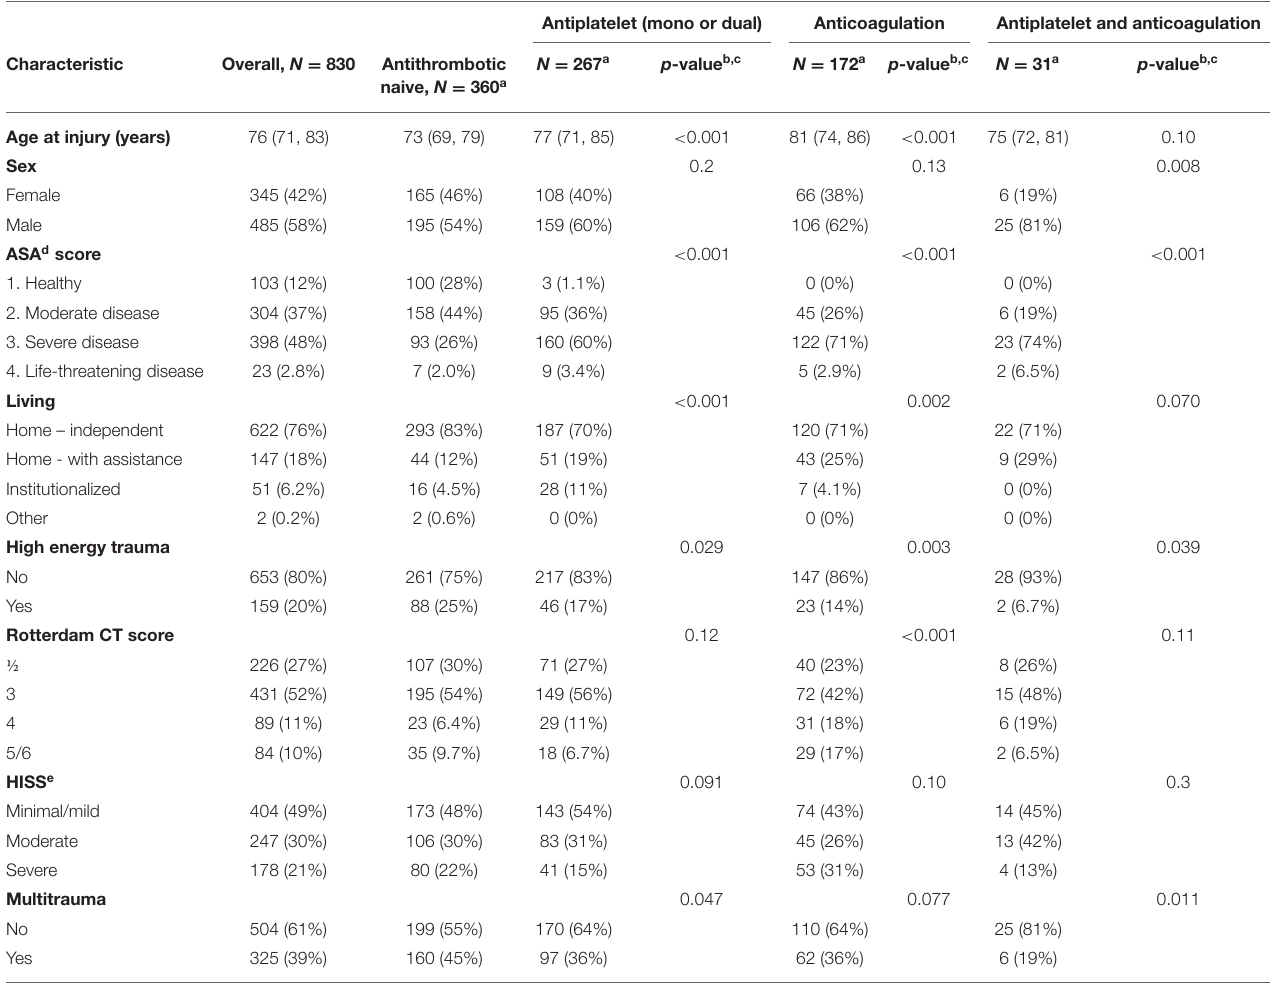
TABLE 2 | Baseline characteristics of the study population. Antiplatelet (mono or dual) Anticoagulation Antiplatelet and